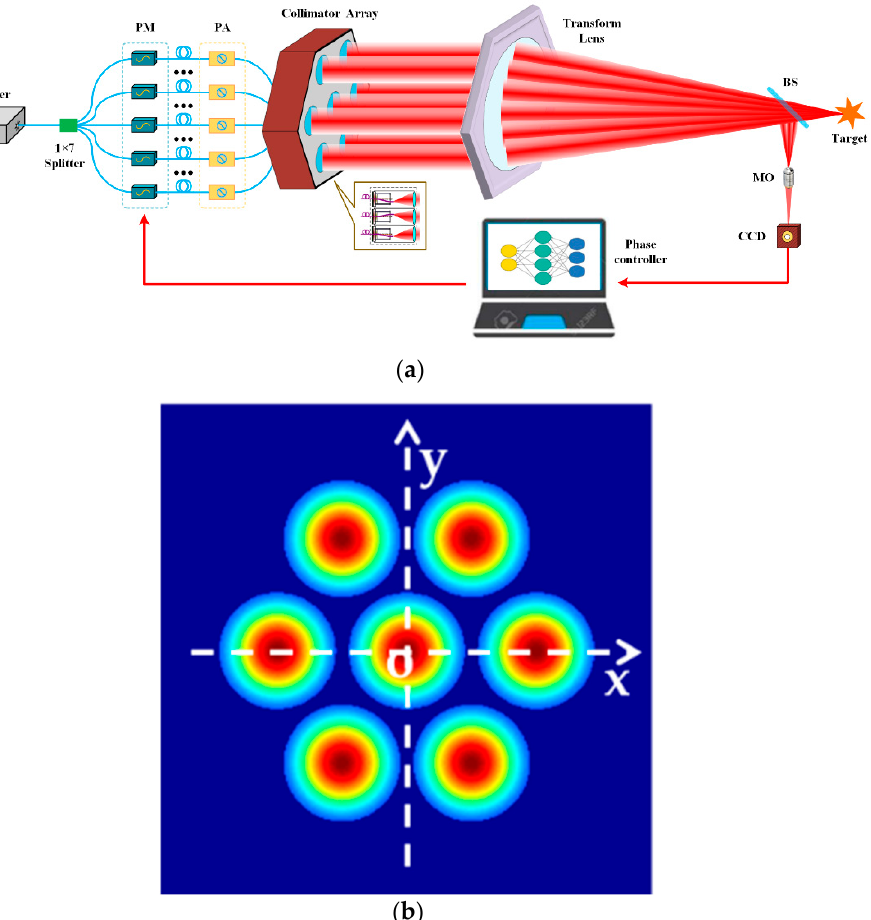
Figure 1. ( a ) The structure of the N-elements CBC system (N = 7 in this diagram); ( b ) Schematic diagram of the emissive plane coordinate system.